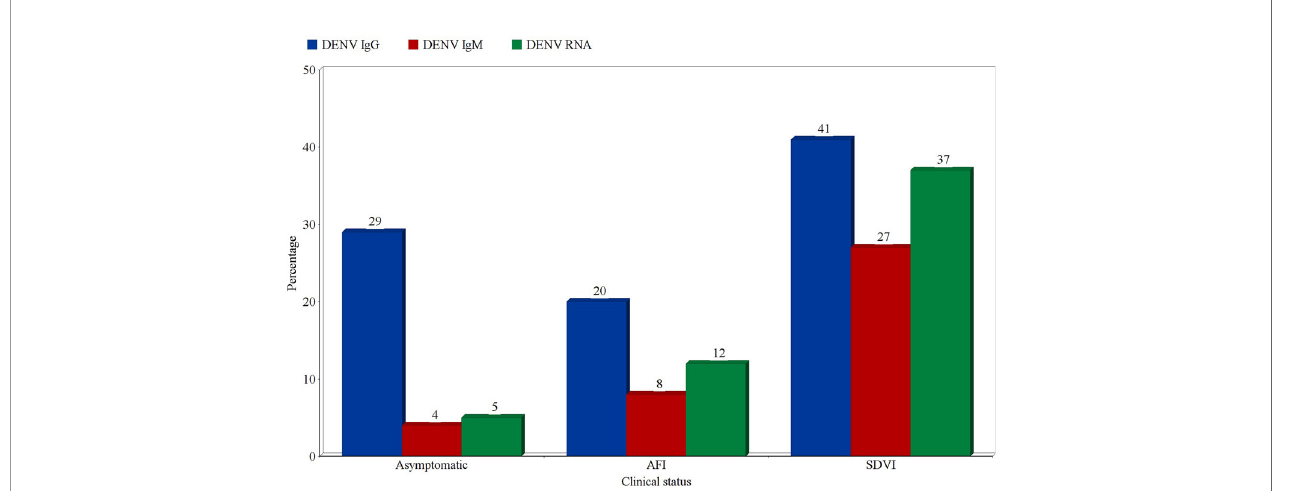
FIGURE 8 | Prevalence estimates of Dengue-speci fi c IgG, IgM, and Dengue virus RNA in asymptomatic participants, patients with acute febrile illness (AFI), and patients with suspected Dengue virus infection (SDVI). Each estimate represents the random effects pooled prevalence of the speci fi ed infection marker from studies focusing on any of these clinically-de fi ned